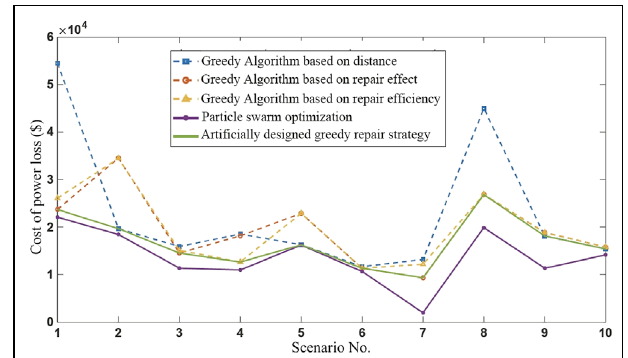
FIGURE 7 | Comparison of repair effects of repair crew dispatch